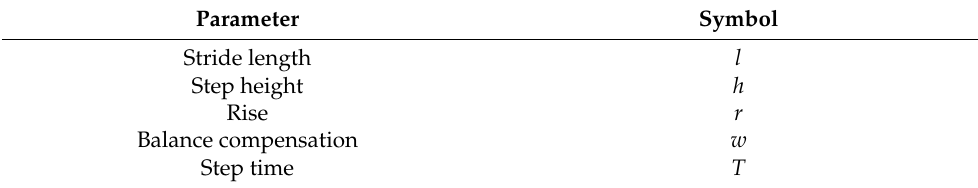
Table 5. Key gait